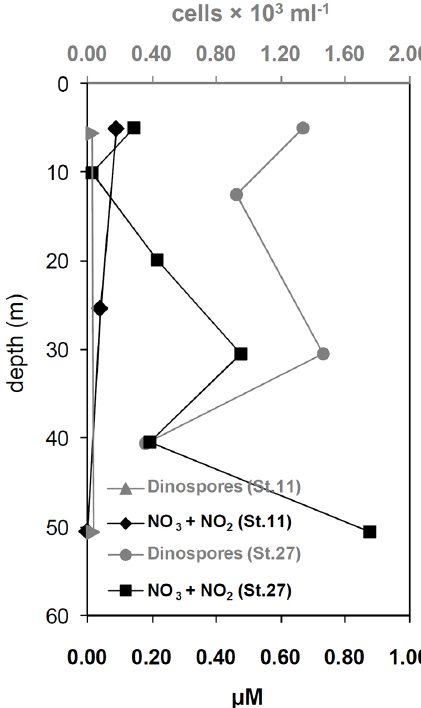
Fig. 3. Dinospore abundances and NO 3 +NO 2 concentrations along the first 50m of the water column at the coastal station 27 at the sta- tion 11, chosen as representative of the ultraoligotrophic conditions of the sampling